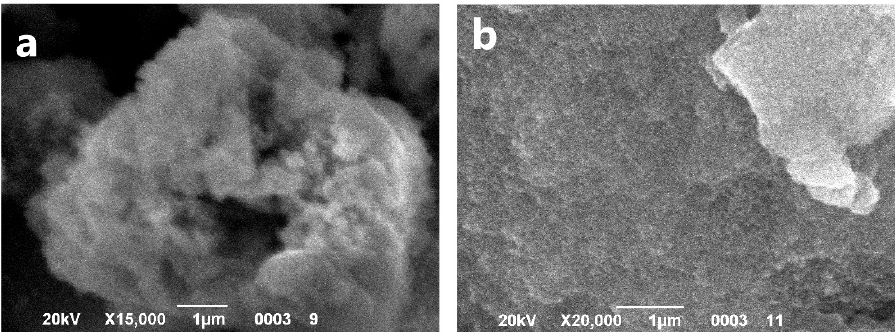
Figure 3. SEM images of the synthesized particles α -Fe 2 O 3 ( a ) and Fe 3 O 4 ( b ).